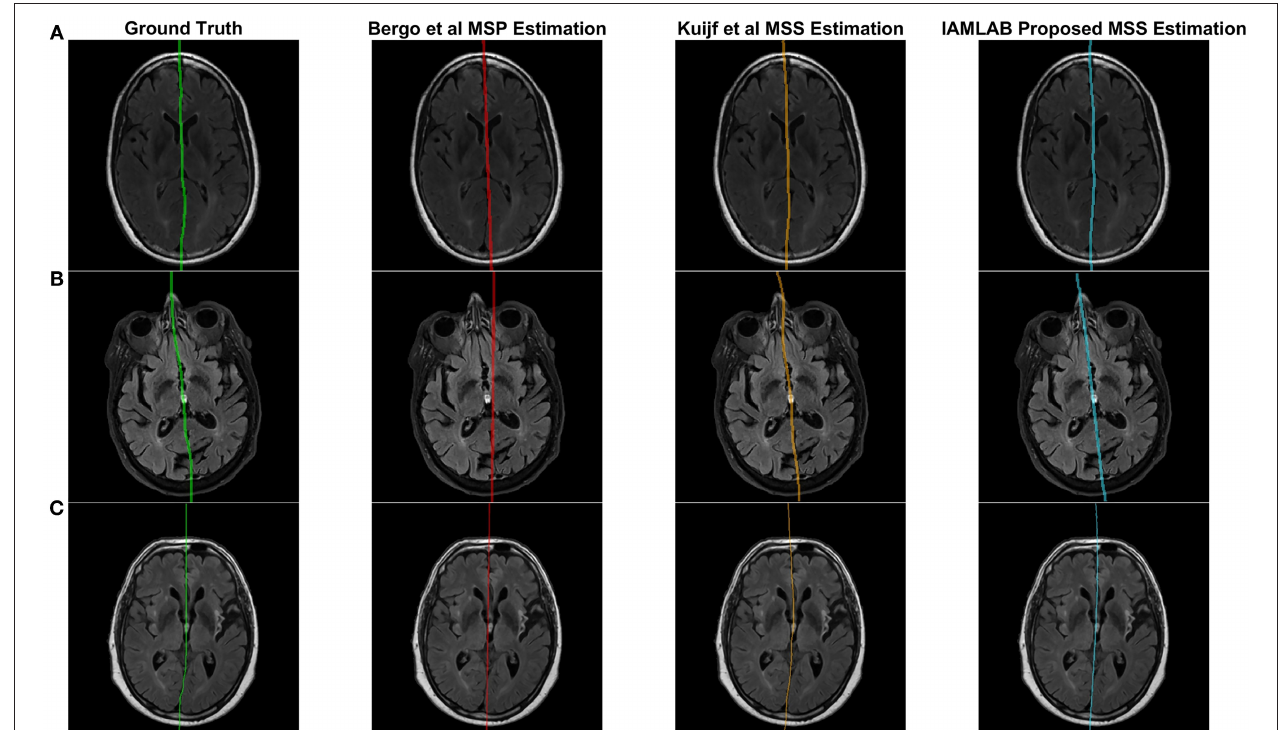
FIGURE 4 | Sample midline estimation results for the proposed method compared to the state-of-the-art. (A) ADNI. (B) CAIN. (C)